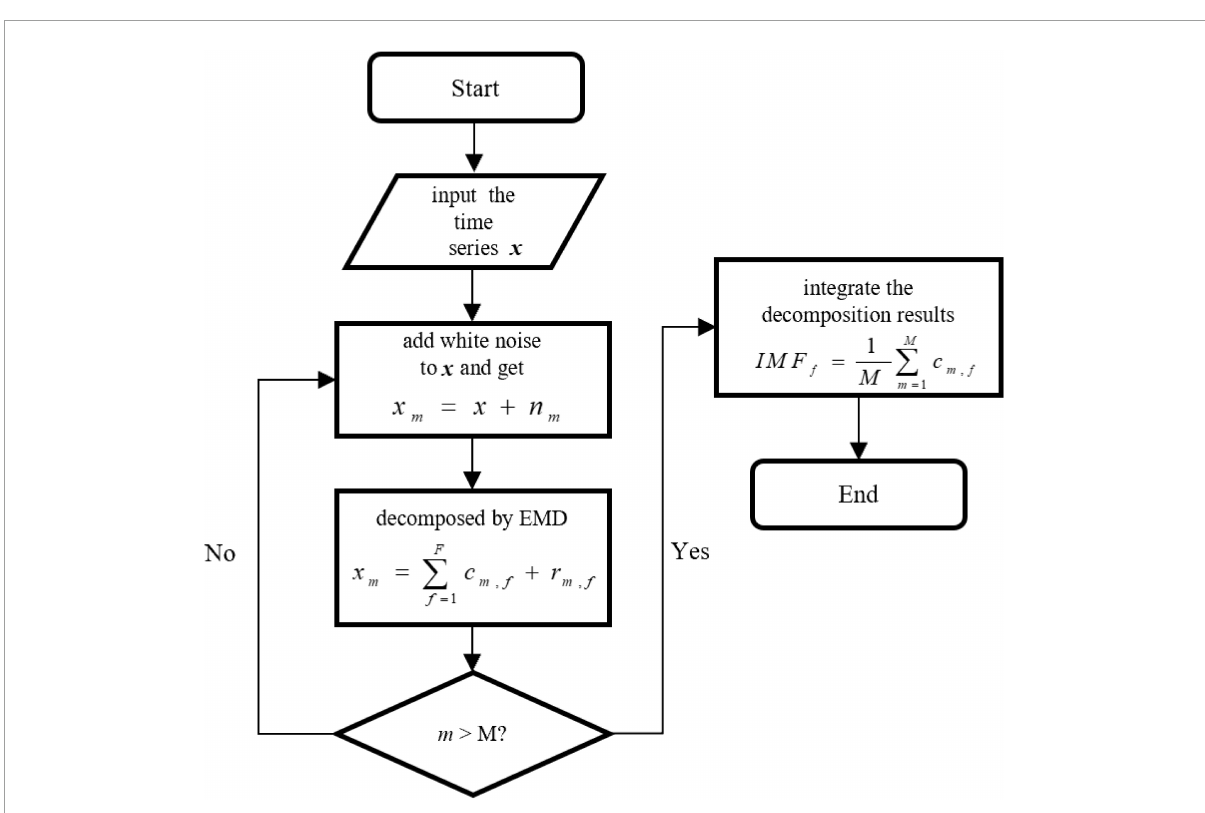
FIGURE2 The algorithm flowchart of ensemble empirical mode decomposition